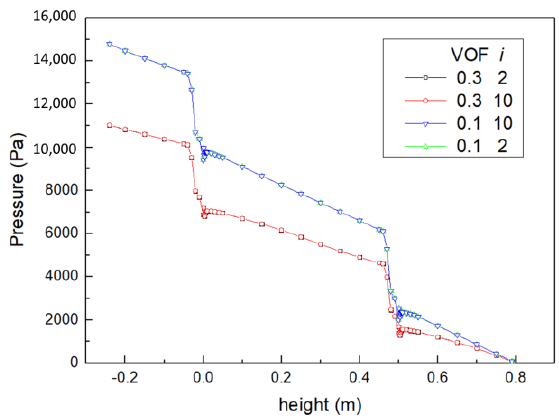
Figure 3. Pressure drop along the flow direction.